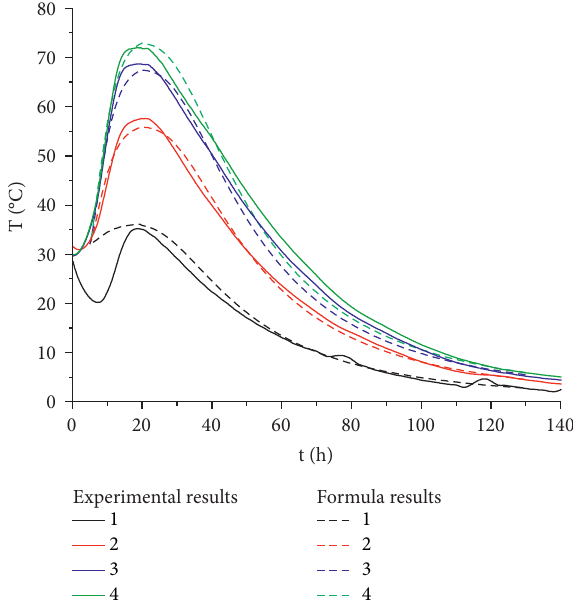
Figure 15: Comparison of experimental and formula-calculated results for the 1.6-m diameter CFST